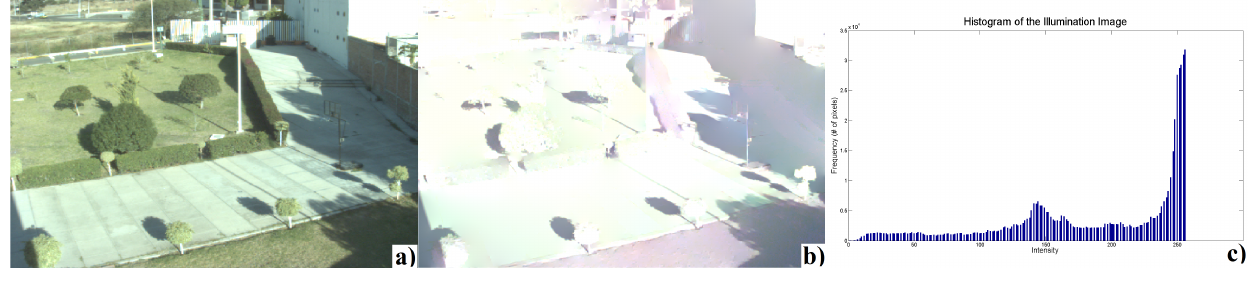
Example of an illumination histogram. ( a ) Input image; ( b ) illumination component computed with the method proposed by Matsushita et al. ; ( c ) Corresponding histogram of the illumination with two Gaussian tendencies. The highest Gaussian tendency corresponds to non-shadow